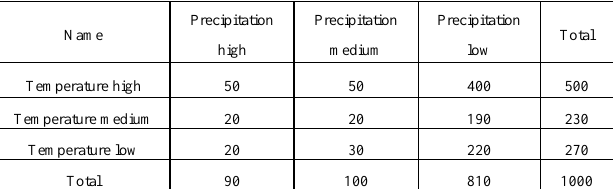
Table 1.The classification results of average daily temperature and precipitation 1000 days （ units: day